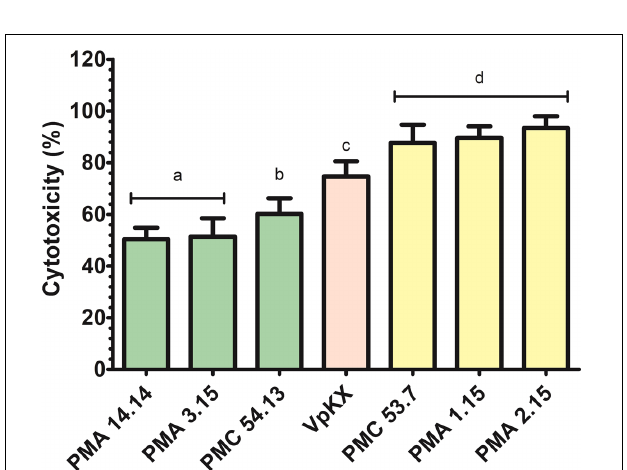
FIGURE 7 | The cytotoxic effect of V. parahaemolyticus strains in Caco-2 cells. The release of lactate dehydrogenase (LDH) into the medium was measured by optical density. Different letters indicate as follows: a, medium cytotoxicity; b, medium-high cytotoxicity; c, high cytotoxicity; and d, very high cytotoxicity. ANOVA post hoc Bonferroni ( p <